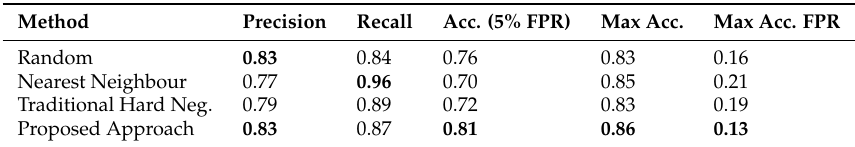
Figure 10. Comparison of training results, in the form of ROC curves, for the matching network performance on a test set when trained using randomly assigned negative pairs to three hard-negatives mining approaches. It can be seen that our proposed approach has a steeper onset than the other approaches, thus indicating better performance during matching. Table 3. Details of SAR-optical matching results under the application of various hard-negative training strategies and at different false positive rates